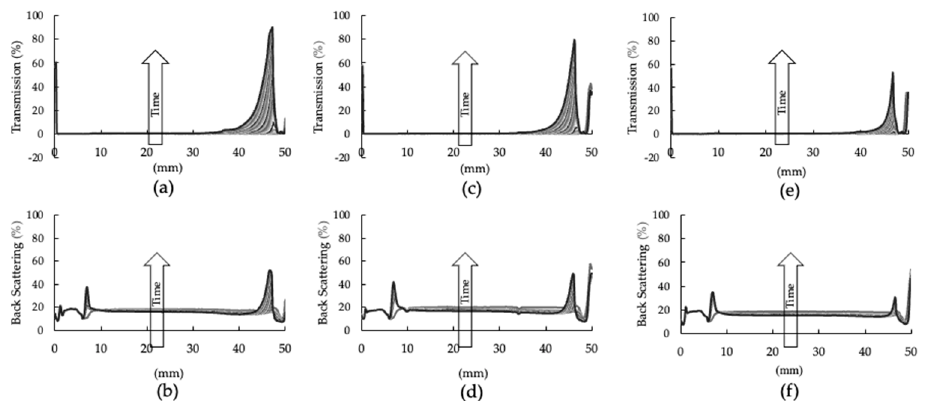
Figure 7. Transmission and backscattering patterns of various suspensions: ( a ) Transmission of RB-T180, ( b ) Back Scattering of RB-T180, ( c ) Transmission of RB − T180 + PVPK-30(PM), ( d ) Back Scattering of RB-T180 + PVPK-30(PM), ( e ) Transmission of RB-T180 + HPC-L(PM), and ( f ) RB-T180 + HPC-L(PM).